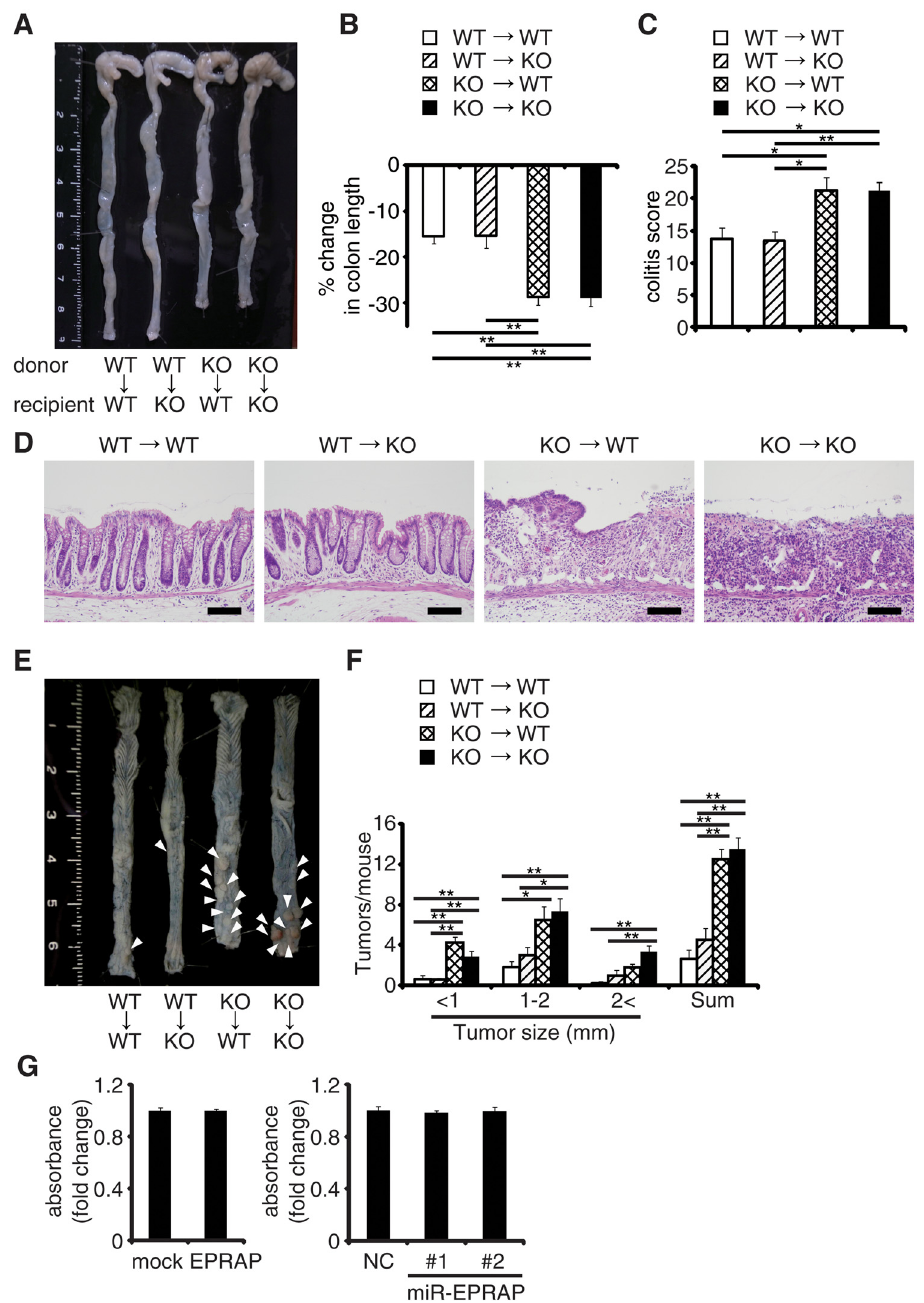
Fig 2. EPRAP in bone marrow – derived cells attenuates colitis and colitis-induced tumorigenesis. Four kinds of chimeric mice were generated by adoptive bone marrow transplantation: (A) Representative photographs of colons with adoptive bone marrow transplantation. (B) Percent changes in colon length expressed relative to DSS-free water controls in each group. (n = 4 – 8 each). (C) Histological colitis scores (n = 4 – 8 each). (D) Representative H&E staining of rectal sections. Scale bars: 100 μ m. (E) Representative photographs of colons at the end of AOM/DSS treatment. (F) The number of colonic tumors per mouse, with the size distribution (left) and the total number (right) in each group (n = 4 – 9 each). (G) EPRAP did not directly affect cell proliferation. DLD-1 cell proliferation was determined by MTS assay (over expression of EPRAP, left; knockdown of EPRAP, right). Data represent fold induction of absorbance compared with mock or negative control. All values represent means ± SEM. * P < 0.05, ** P <